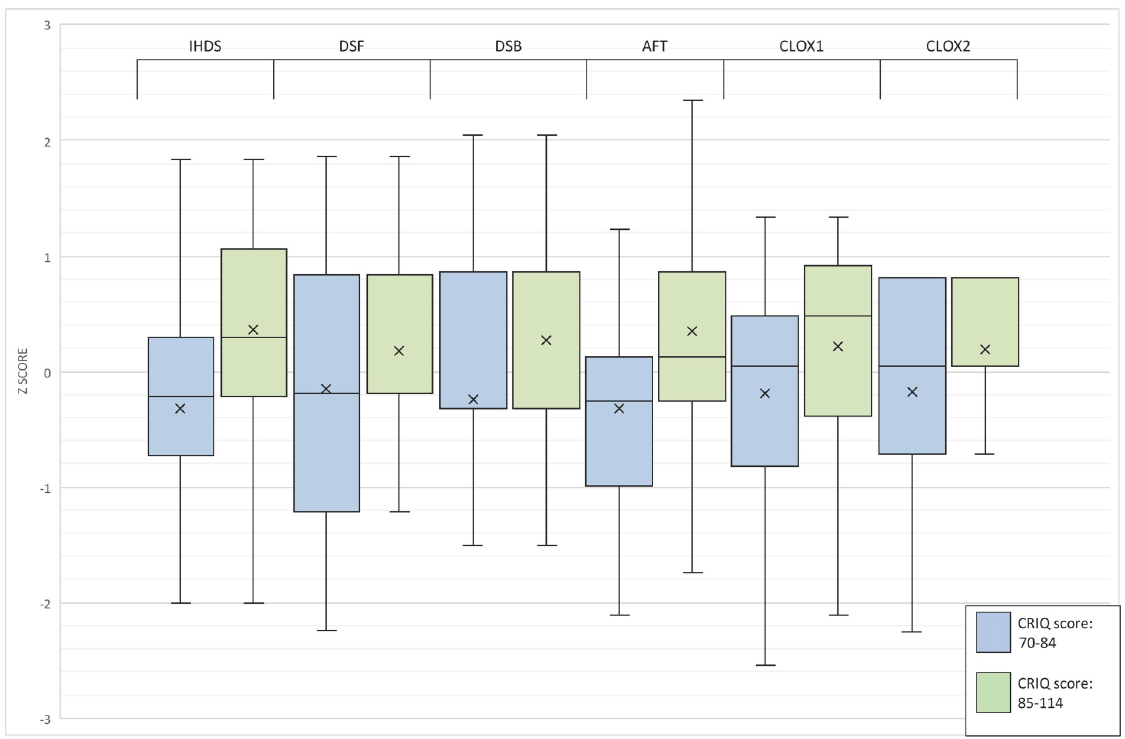
Fig 1. Box and whisker plot of averaged neuropsychological test performance z scores according to Cognitive Reserve Index categories.